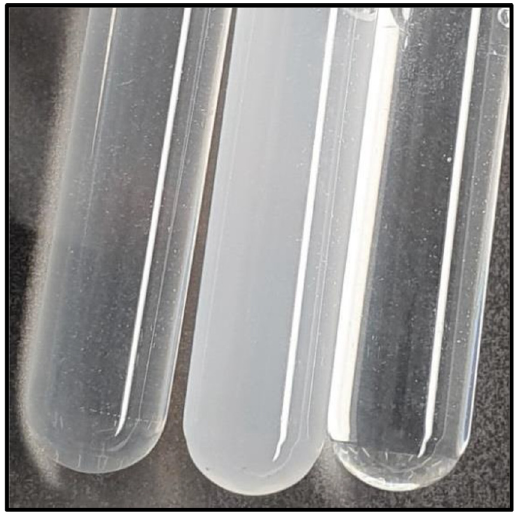
Figure 1: Mixture of ganciclovir sodium (G) 3.5 mg/mL diluted in 0.9% sodium chloride with posaconazole (P) 1.2 mg/mL diluted in 0.9% sodium chloride after the mixture (G:P (v:v): glass tube left to right, n ° 1: 9:1, n ° 2: 1:1, n ° 3: 1:9).